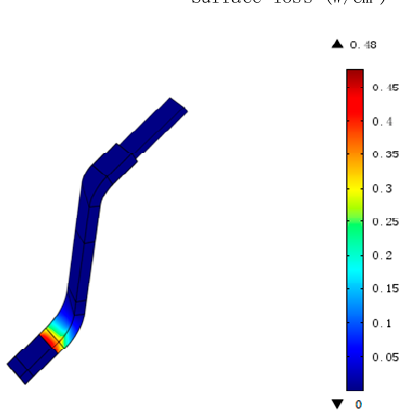
Figure 10. Surface loss distribution of the three-segment nonlinear corona protection layer.